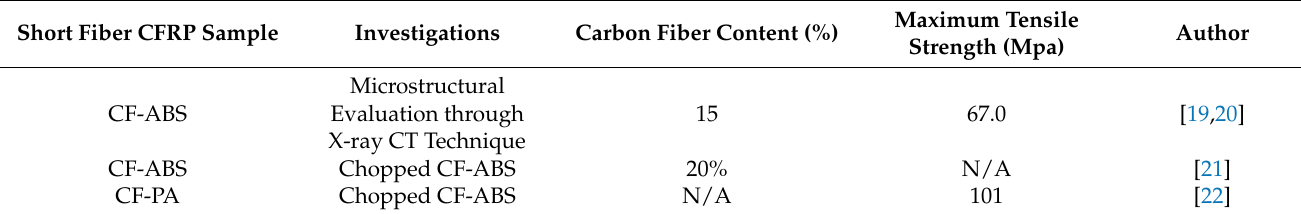
Table 1. Summary of Reported Investigations on the Compressive Properties of AM Fabricated CFRP Composites. Short Fiber CFRP